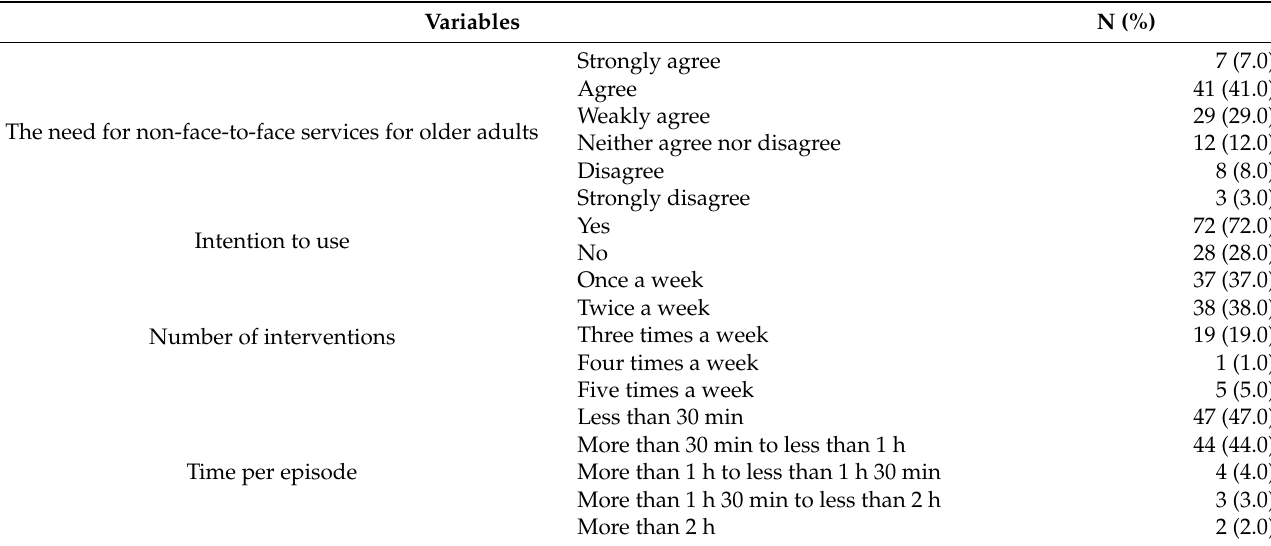
Table 2. Non-face-to-face services’ perception and necessity (N =